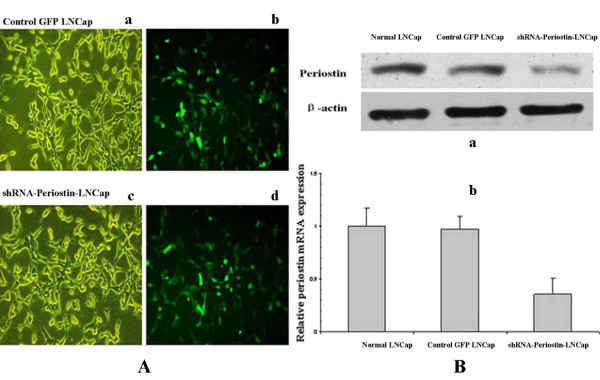
The efficacy of shRNA lentiviral particles transfection. A: Compared with LNCap cells transducted with the control GFP lentiviral particles (a) and shRNA-Periostin lentiviral particles(c) under common microscope, it could be seen that the effective rate of trusduction was more than 90% under fluorescence microscope(b and d). B: a:The Periostin protein expression was significantly reduced by shRNA-Periostin(P <0.05). b:The level of mRNA of Periostin after transducting shRNA-Periostin lentiviral particles was decreased by nearly 80% (P <0.05). Control GFP lentiviral particles had no influence on the Periostin expression of LNCap cells.